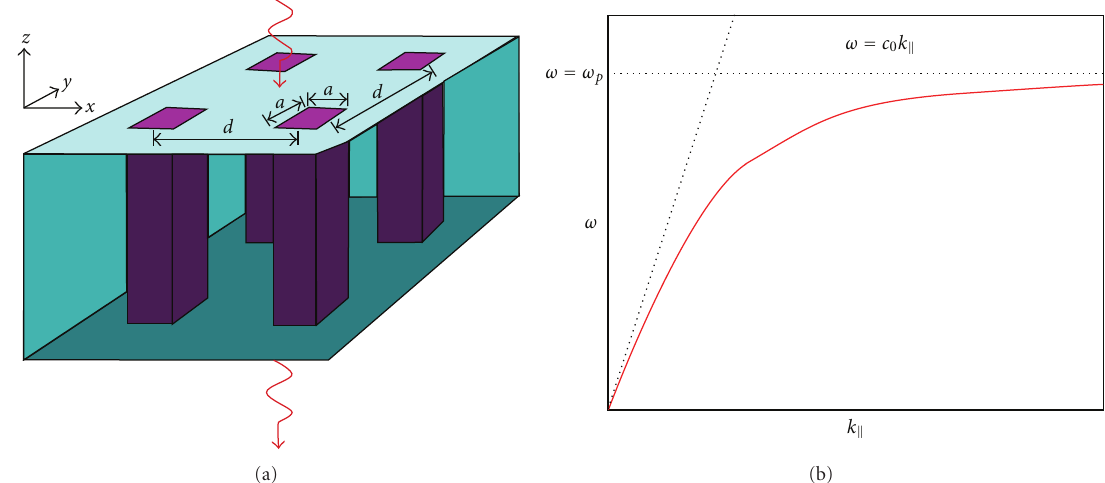
Figure 9: Spoof plasmonics in PEC shown by dimension (a) and dispersion (b) [43].